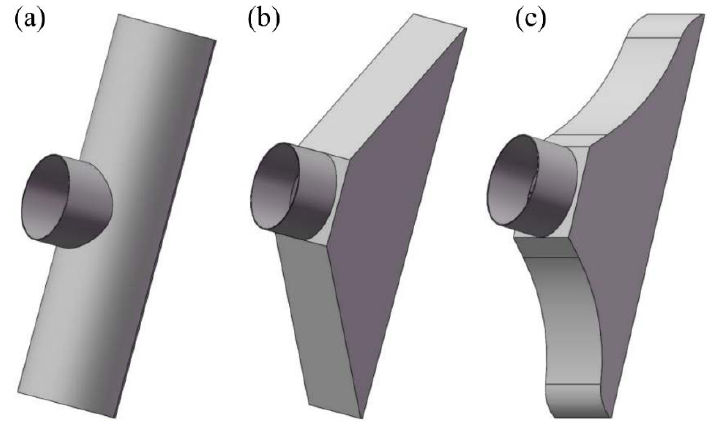
Figure 6. Three typical transition ducts: ( a ) Direct transition duct; ( b ) triangle transition duct; ( c ) quasi-parabola transition duct.